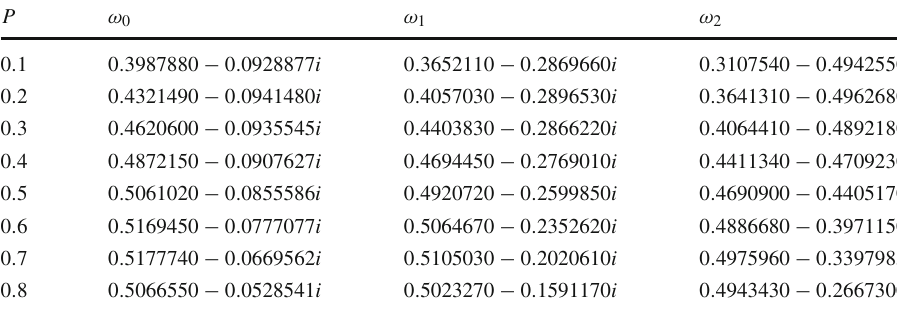
Table 1 The first LQBH’s quasinormal modes for l =